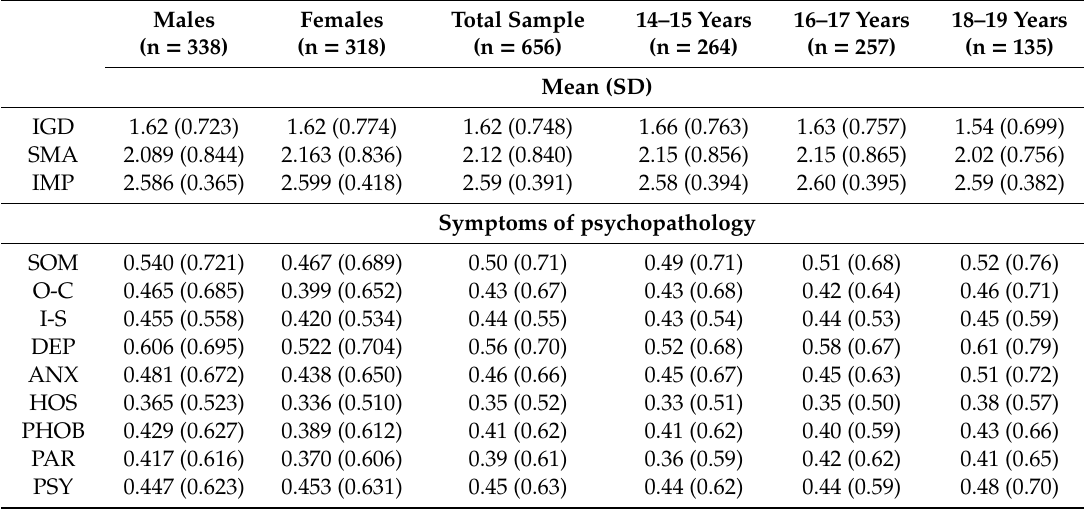
Table 1. Descriptive statistics for the variables of interest (total sample, gender and each age